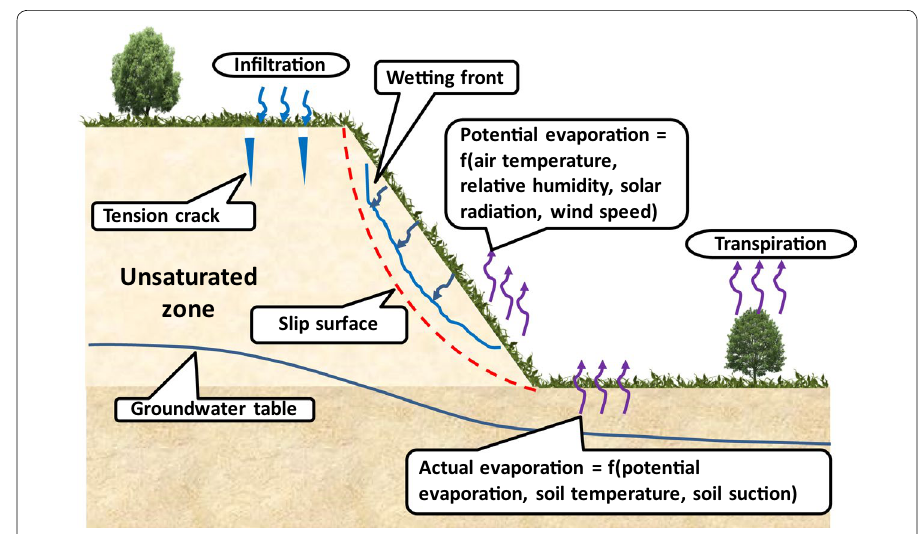
Fig. 1 Mechanism of rainfall-induced slope